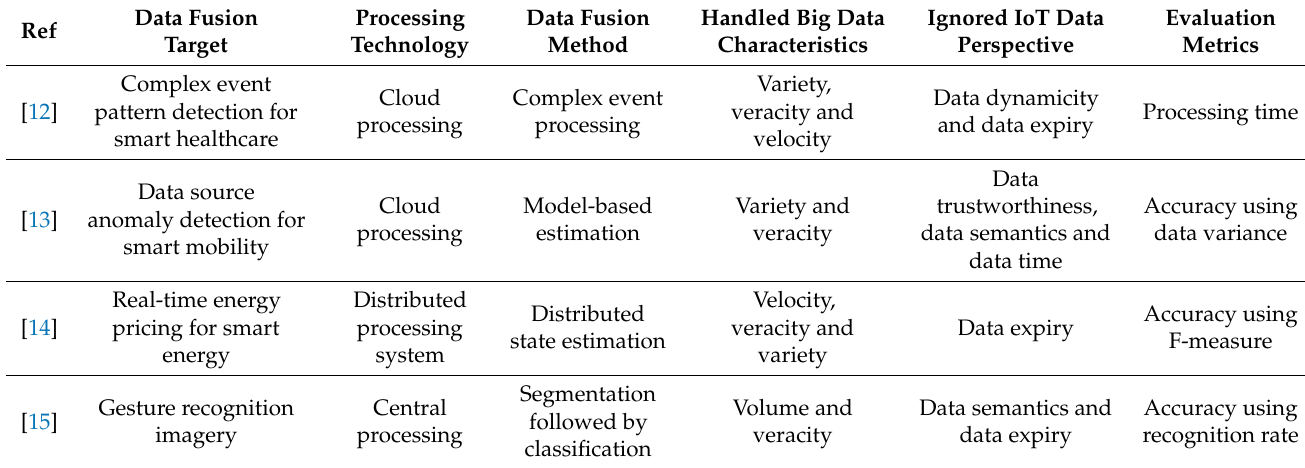
Table 1. Evaluation of data fusion methods in IoT systems from the big data and IoT